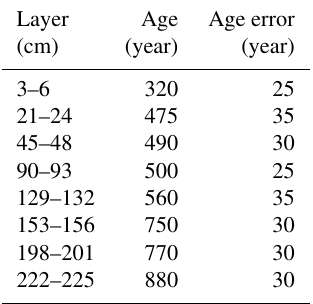
Table 1. Age estimates of the sediment